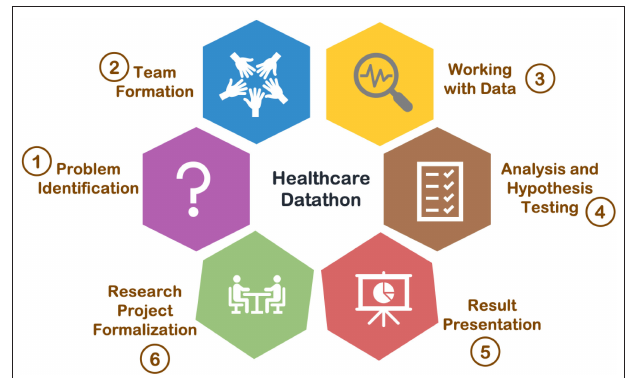
FIGURE 1 | Process of a healthcare